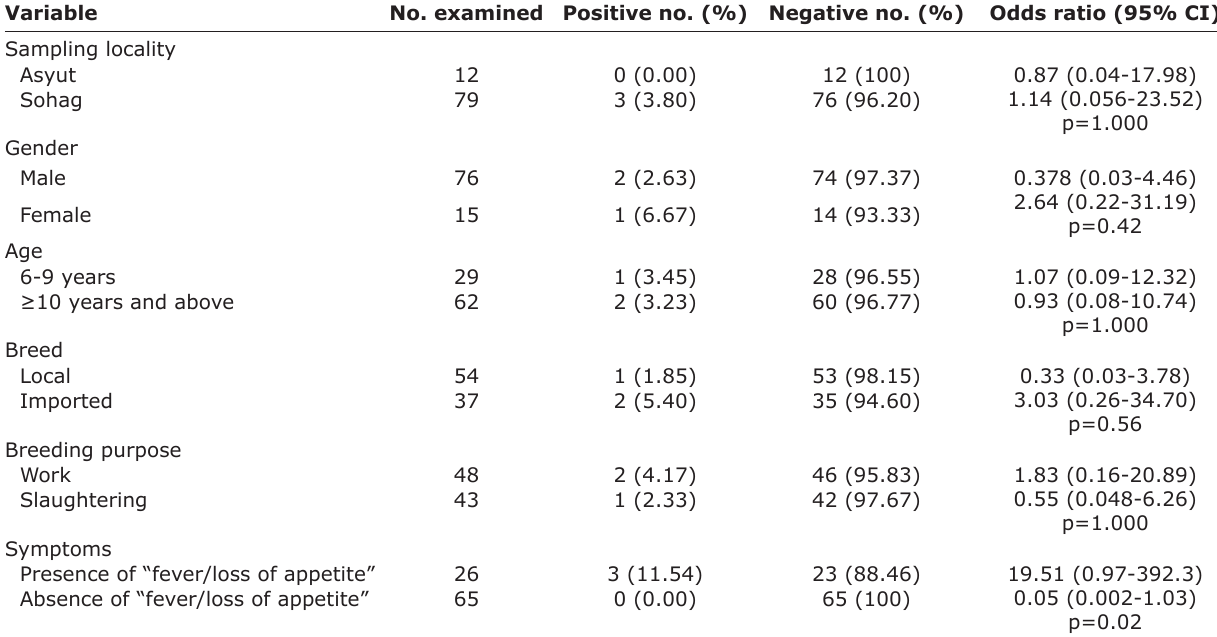
Table-3: Impact of different factors on dengue virus seropositivity in camels.